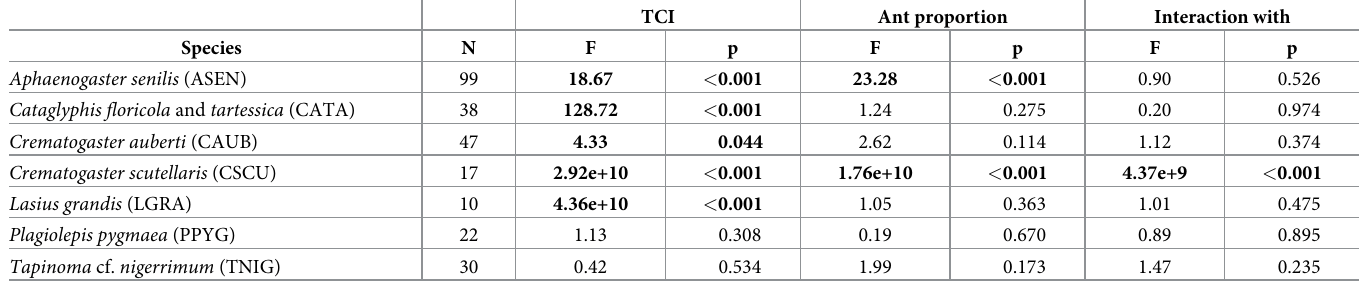
Table 1. Number of bait observations (N) and effects of TCI (thermal competition index), relative ant proportion and interaction with, on the probability of having success during the interaction. TCI Ant proportion Interaction with Species